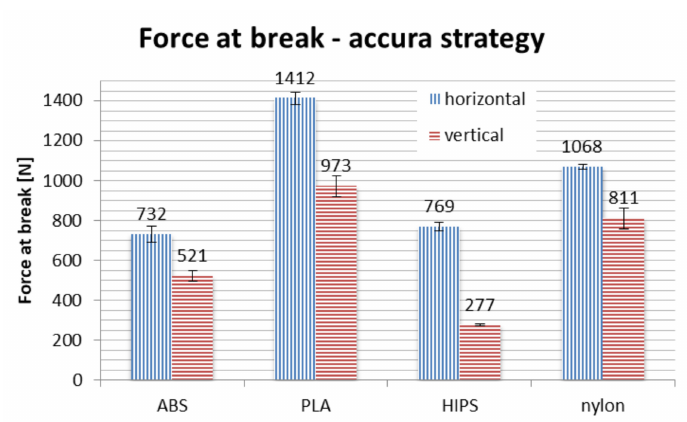
Figure 16. Strength of manufactured orthoses—econo strategy.